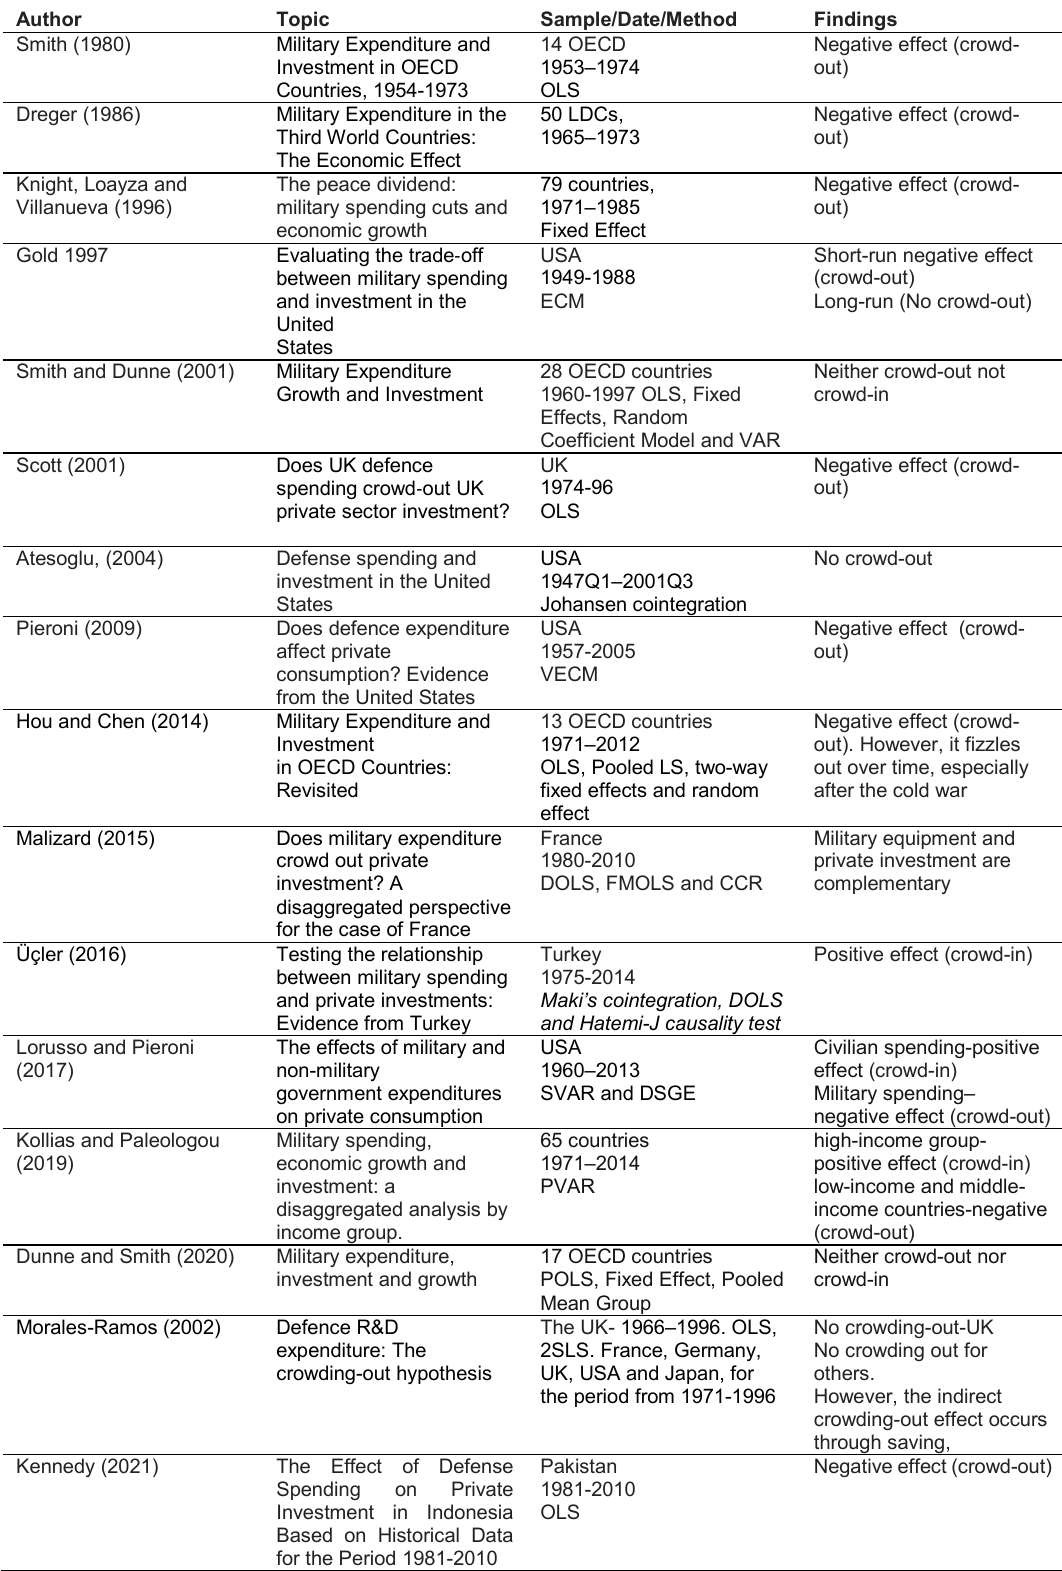
Table 1. Literature review: summary table.